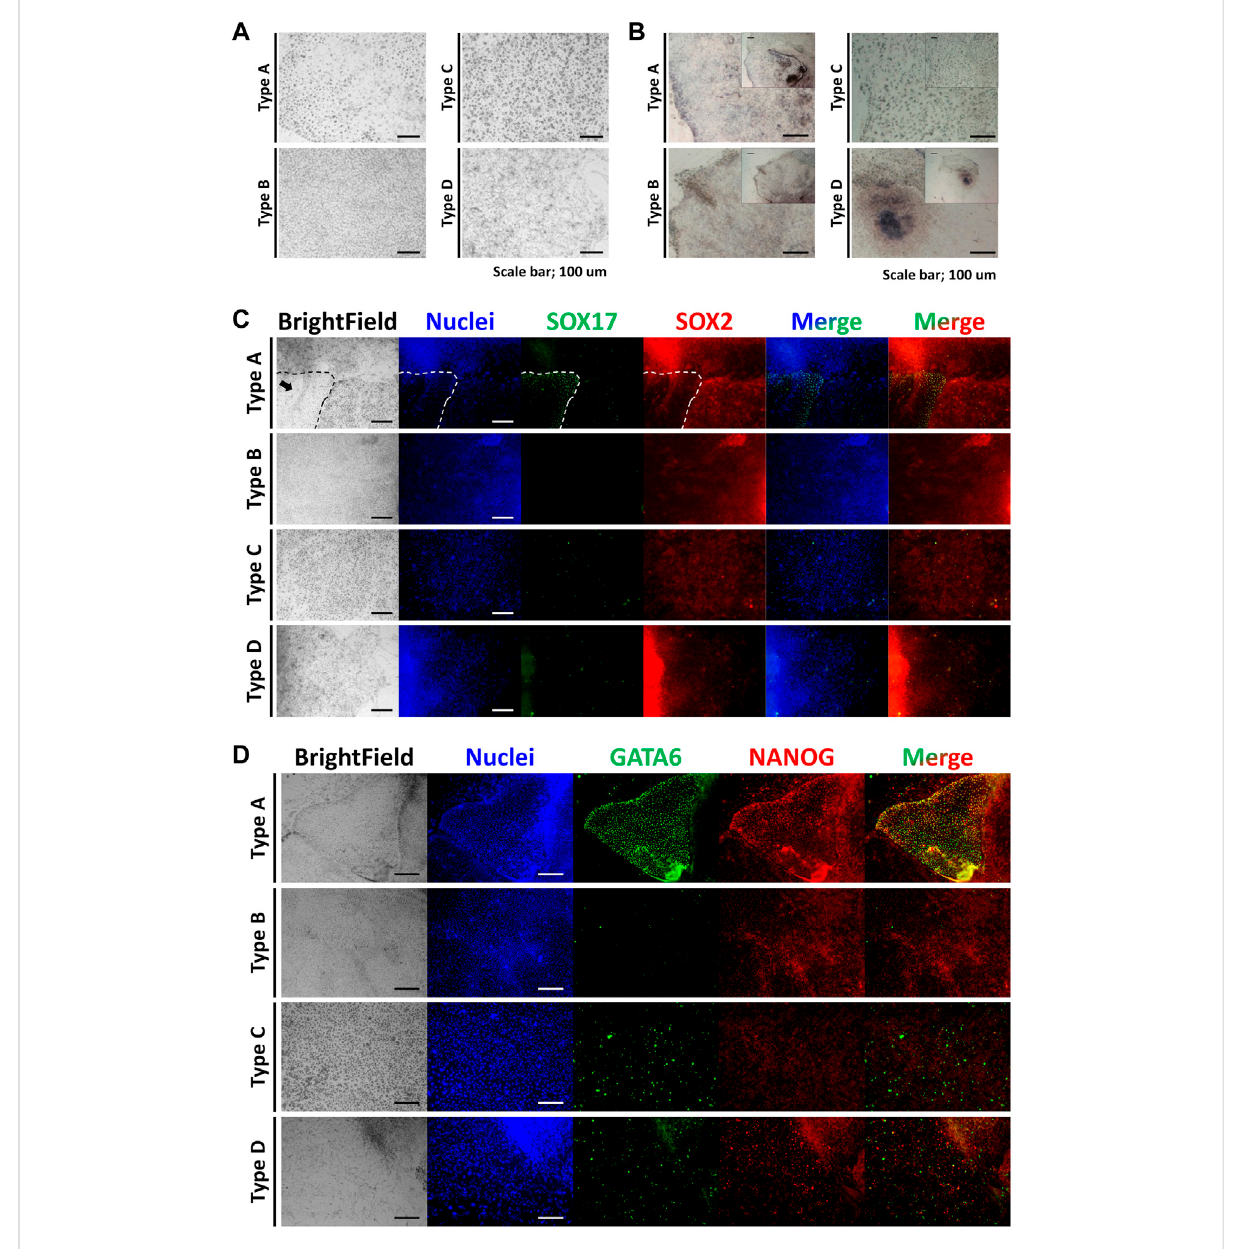
FIGURE 1 Morphologies, alkaline phosphatase staining, and immunocytochemistry of the four types of cells. (A) Morphologies of the four cell types. (B) Alkaline phosphatase staining of the four cell types. (C) Immunocytochemistry staining images of the four cell types for SOX17 and SOX2 (the arrow indicates the area oftype A cells). (D) Immunocytochemistrystaining imagesof thefour cell types for GATA6 and NANOG. All scale bars are 100 μ